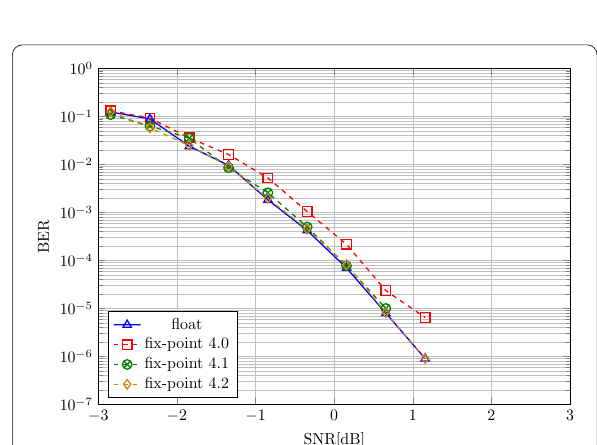
float fix-point 4.0